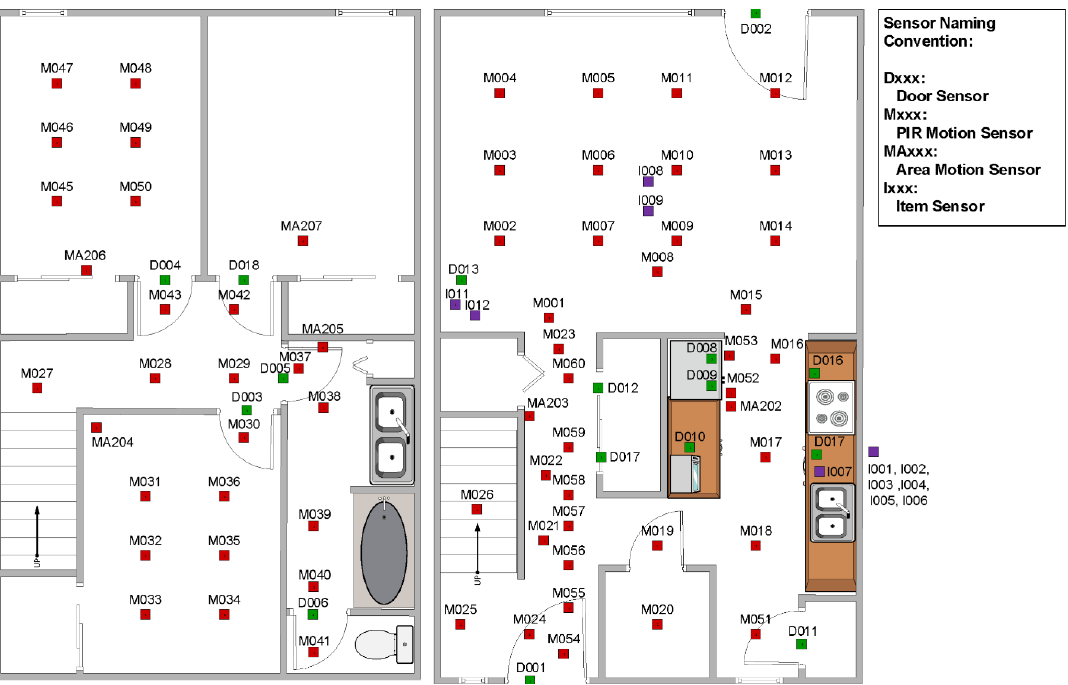
Figure 2. Floor plan and sensor locations for an on-campus smart home testbed. Motion/light sensor locations are indicated with red squares and door/temperature sensor locations are indicated with green squares. Purple squares indicate the locations of items that are tagged with additional sensors. Table 1. An example of sensor messages recorded from the on-campus smart home testbed. Each sensor message contains the message date / time, the sensor ID, and the sensor